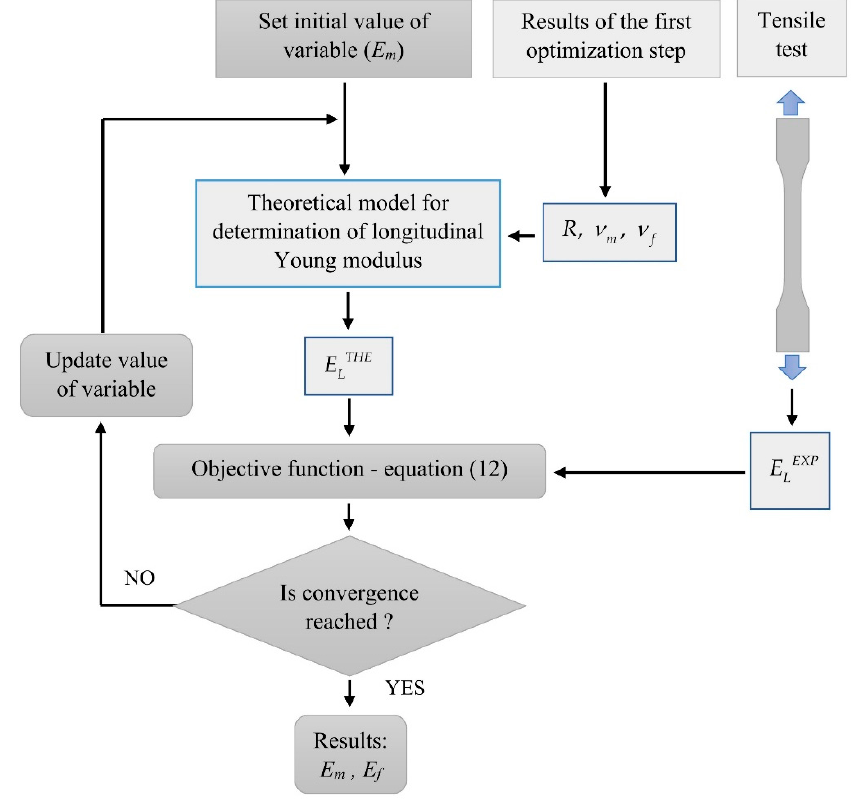
Figure 4. Scheme of the second optimization step.